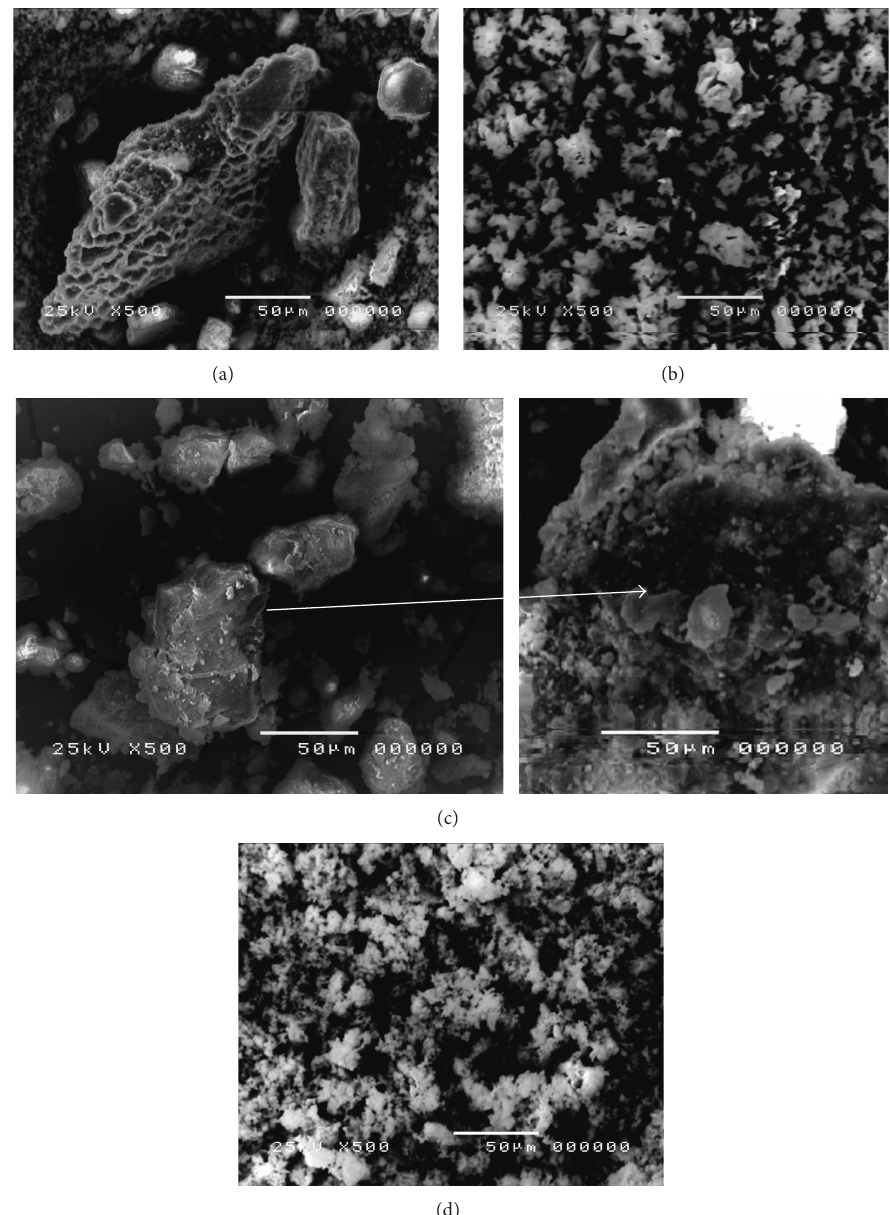
Figure 5: SEM images of natural mollusks shells (a), calcined mollusks shells at 800 ∘ C (b), natural crabs shells, (c) and calcined crabs shells at 700 ∘ C